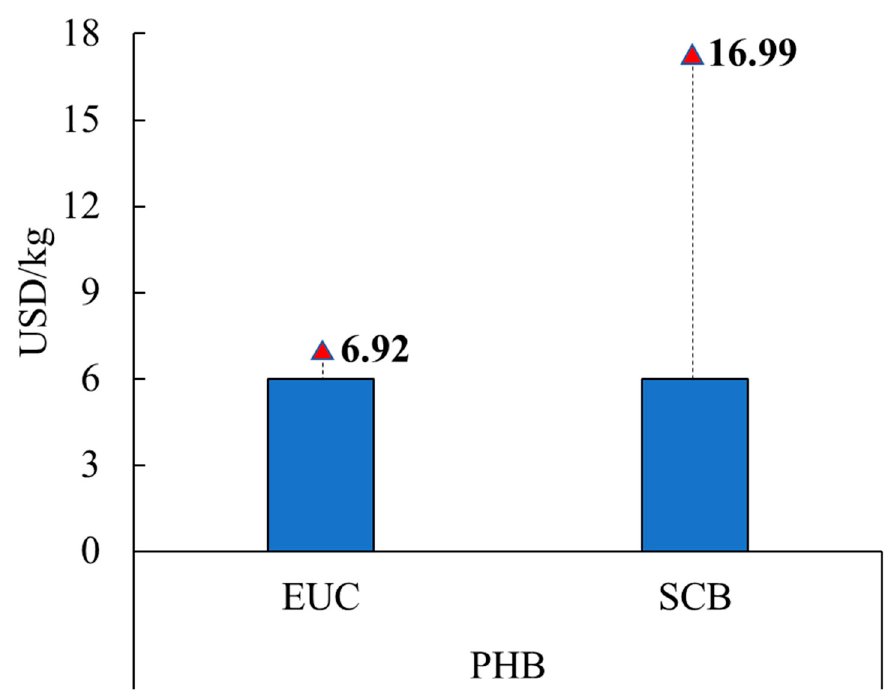
Figure 7. PHB minimum selling price to reach positive NPV. For the scenarios of EUC and SCB with acetate.